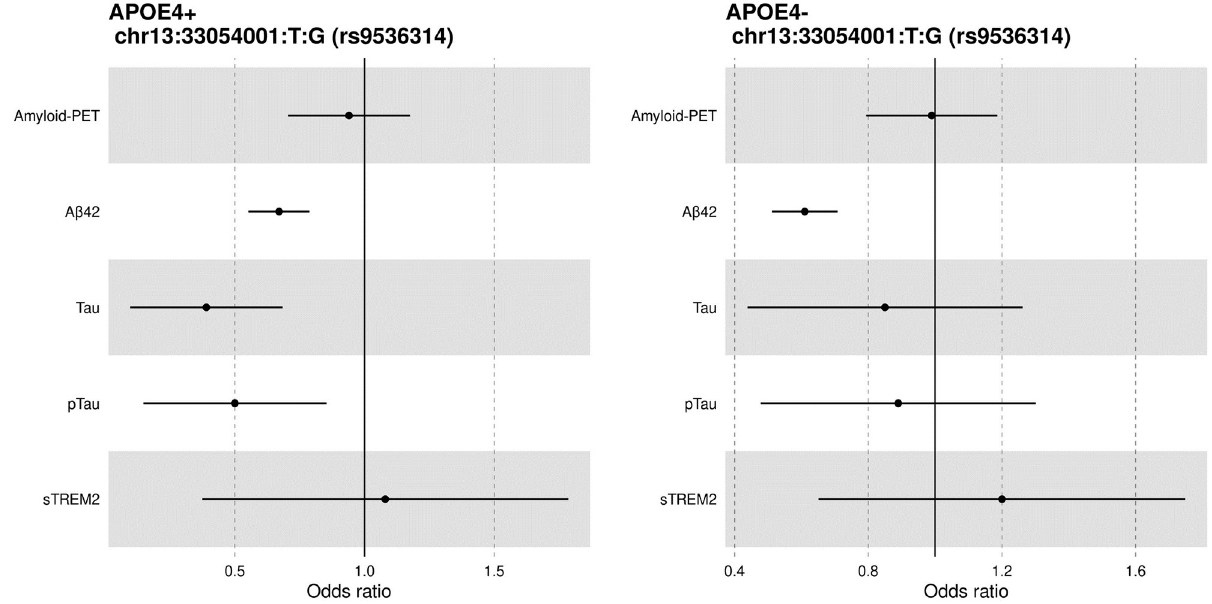
Fig 3. Forest plot of odds ratio (OR) for KL-VS HET+ association with dichotomized AD endophenotypes in 60–80 year cognitively normal participants, stratified by APOE ε 4 status. A significant association was detected between KL-VS HET+ and dichotomized A β , Tau, and pTau CSF levels. In case of A β , the associations were deemed significant across both APOE ε 4 strata, whereas for Tau and pTau, associations were observed only in APOE ε 4-carriers, representing an exclusive protective effect of KL-VS HET+ for the cognitively normal participants aged 60 to 80 years and carrying APOE ε 4. Abbreviations: APOE 4+, Apolipoprotein E 4 positive; APOE 4-, Apolipoprotein E 4 negative; PET, positron emission tomography; A β , β - amyloid; pTau, phosphorylated tau181; soluble triggering receptor expressed on myeloid cells 2, sTREM2.